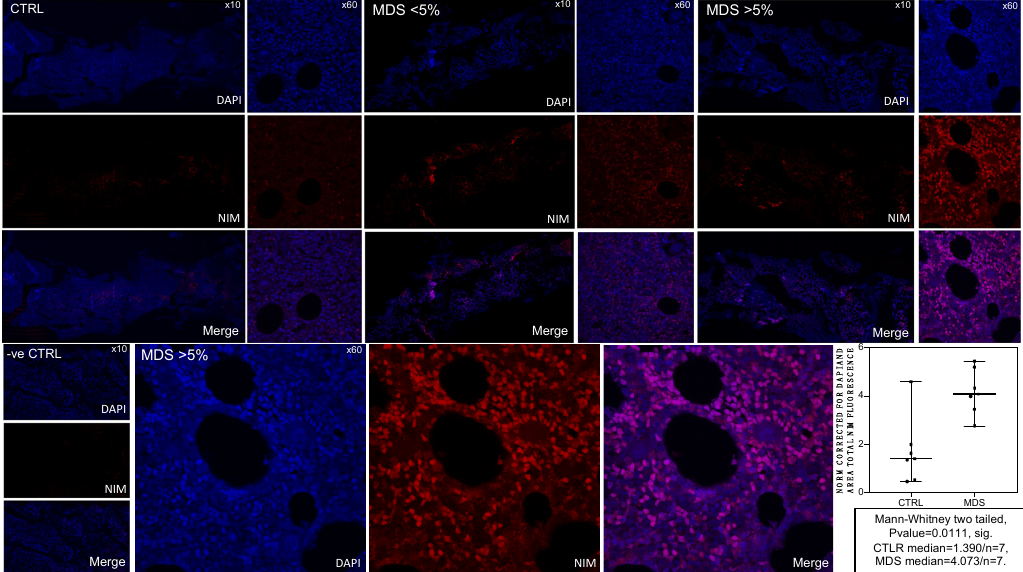
Figure 2. Bone marrow biopsy nitroimidazole derivative (NIM)-indocyanine (IDC) (Red) immunofluorescence from control (CTRL/n = 7) and MDS (n = 7) subjects. One representative CTRL, and two MDS along with the negative control (-ve CTRL) samples are presented. 4.6-diamidino-2-phenylindole (DAPI) (Blue) was used as a contrast stain given its very different excitation and emission spectrums with NIM-IDC. Both whole section tile scans ( × 10 and × 20) along with corresponding close-ups ( × 60) are shown. Close ups form the MDS ≥ 5 % intra BM blast counts are also shown enlarged to visualize the intracellular NIM-IDC staining. Colocalization of NIM-IDC with DAPI is attributed to up-regulated apoptosis and was corrected when calculating the NIM-IDC fluorescence along with differences in area section. For two out of seven CTRL and MDS samples, two sections from different depths within the biopsy specimen were microscopically observed to ensure method accuracy. We show statistically significant intracellular NIM-IDC immunofluorescence in MDS samples with its accumulation increasing directly with the severity of MDS. Of note, MDS severity is also visually directly associated with apoptotic burden, which is further analyzed in the main text. ns: non significant, sig.: significant. Mann–Whitney p -value > 0.05 or <0.05